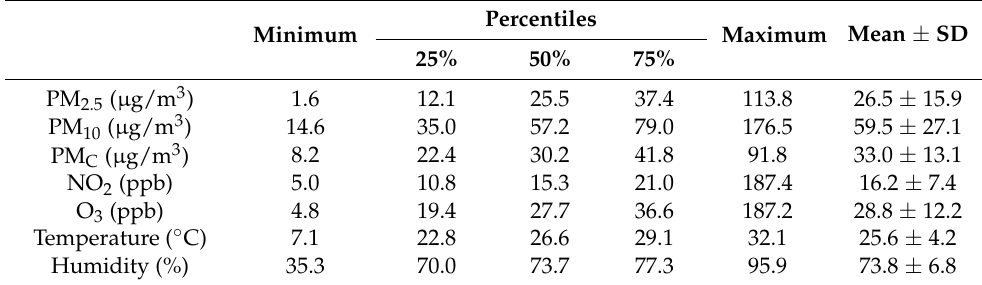
Table 2. Summary statistics for meteorological factors and air pollutants during the study period in